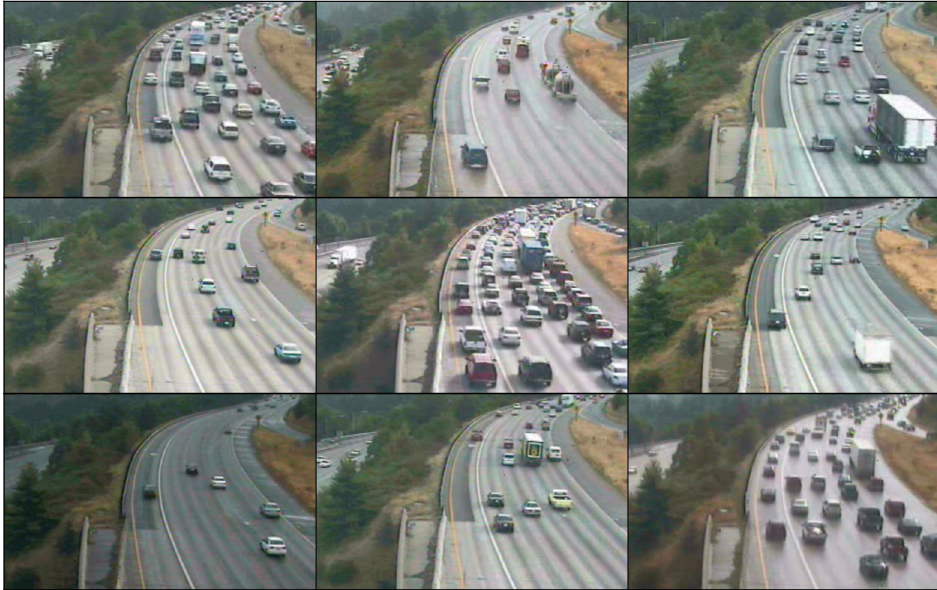
Figure 3. Examples of UCSD